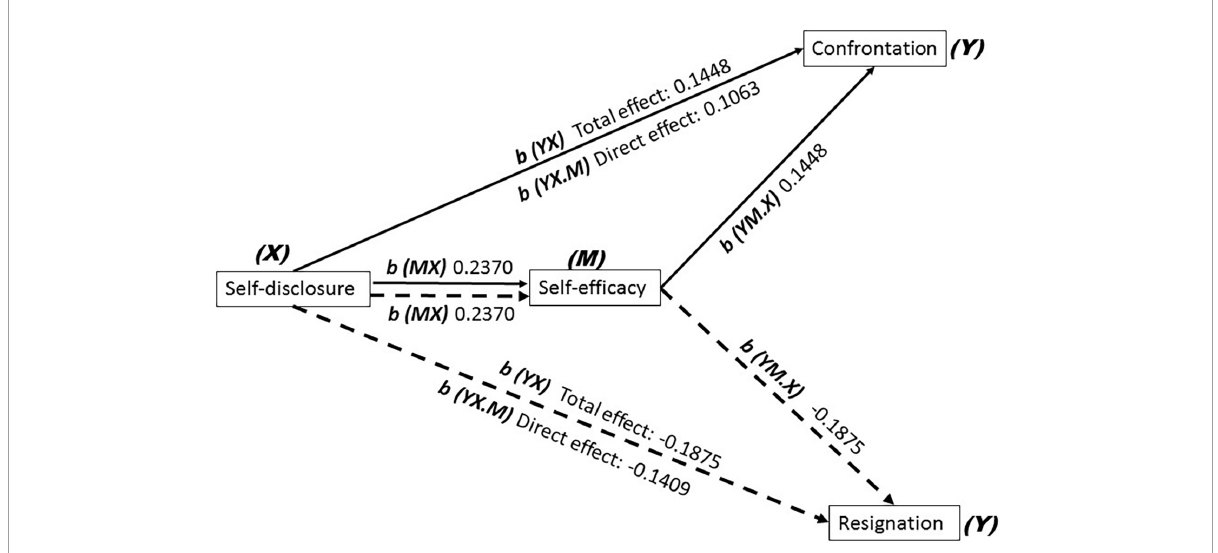
FIGURE2 On admission, Confrontation and Resignation coping strategies of adolescents with depression were, respectively used as Y , and mediation analysis results showed that Model b (YX) (total effect, b = 0.1448 for Confrontation , and b = –0.1875 for Resignation ; both p < 0.001), Model b (MX) ( X – > M , for both Confrontation and Resignation, b = 0.2370, p < 0.001), Model b (YM.X) ( M – > Y , b = 0.1448 for Confrontation , and b = –0.1875 for Resignation ; both p < 0.001), Model b (YX.M) ( X – > Y , b = 0.1063 for Confrontation and b = –0.1409 for Resignation ; both p < 0.001). The coefficient of indirect of Confrontation and Resignation was 0.0385 and –0.0466 ( X – > M – > Y , for Confrontation and for Resignation ).